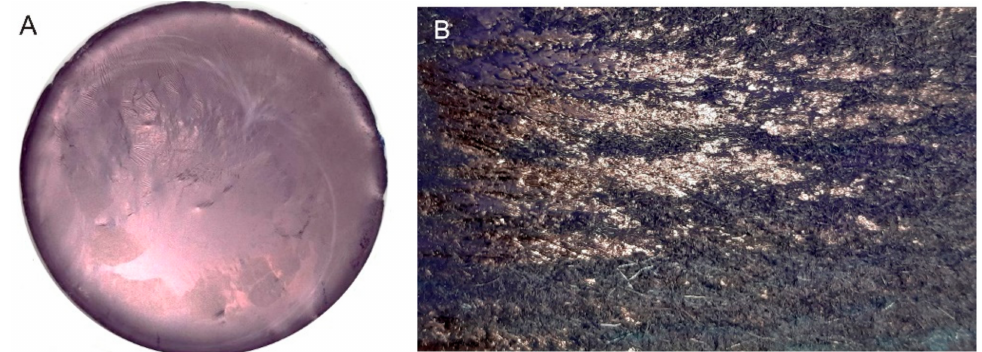
Figure 3. ( A ): indigo layer formed upon filtration. ( B ): pure E-indigo on a friction felt. The metallic luster observed on both photographic images indicates that larger indigo structures have formed by self-assembly from suspension or by friction, respectively